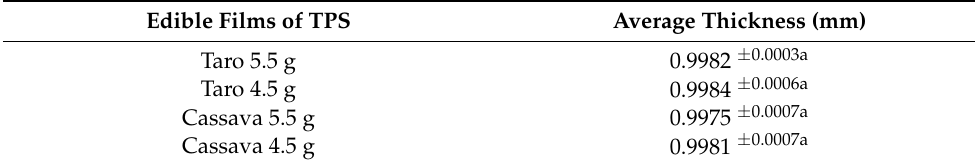
Table 8. Thickness of edible films of starch.